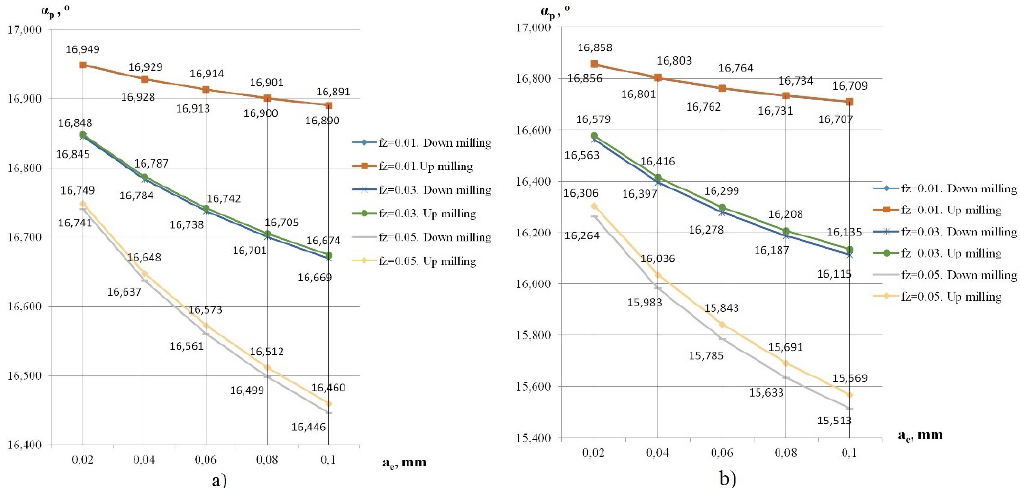
Fig. 5. Dependencies of the kinematic clearance angle α р on radial depth of cut a e with feeds per tooth of 0.01, 0.03 and 0.05 mm for micro end mills: a) d =1 mm, b) d